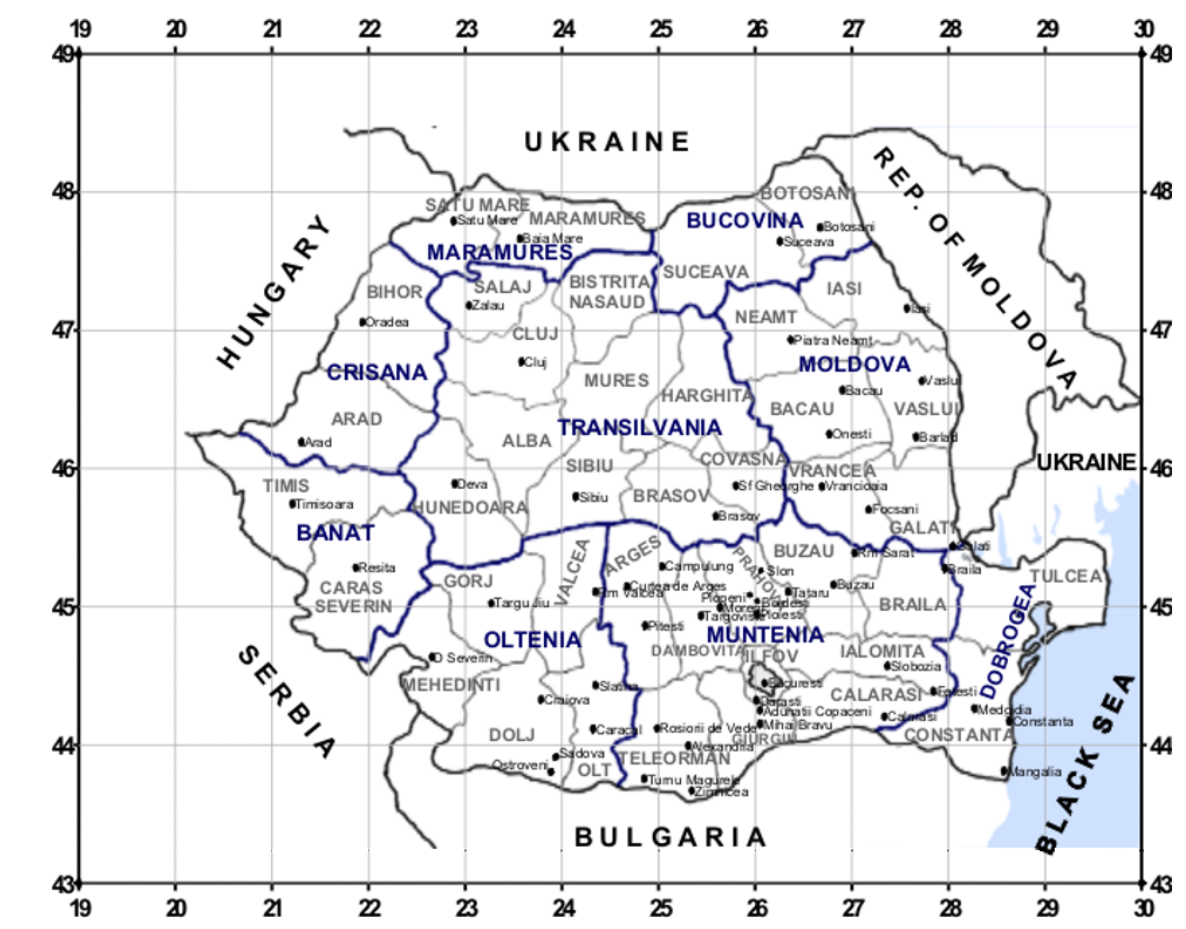
Figure 3. Romanian regions: counties and places mentioned in the text and in Table